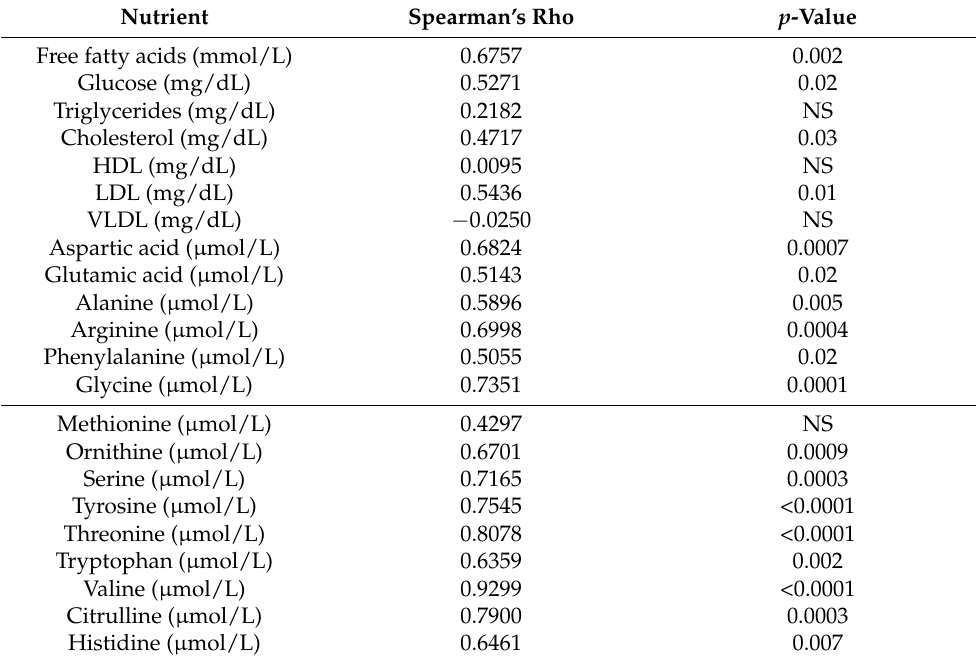
Table 4. Correlations between maternal circulating nutrient levels and the same nutrient level in umbilical vein from CON and ICSI